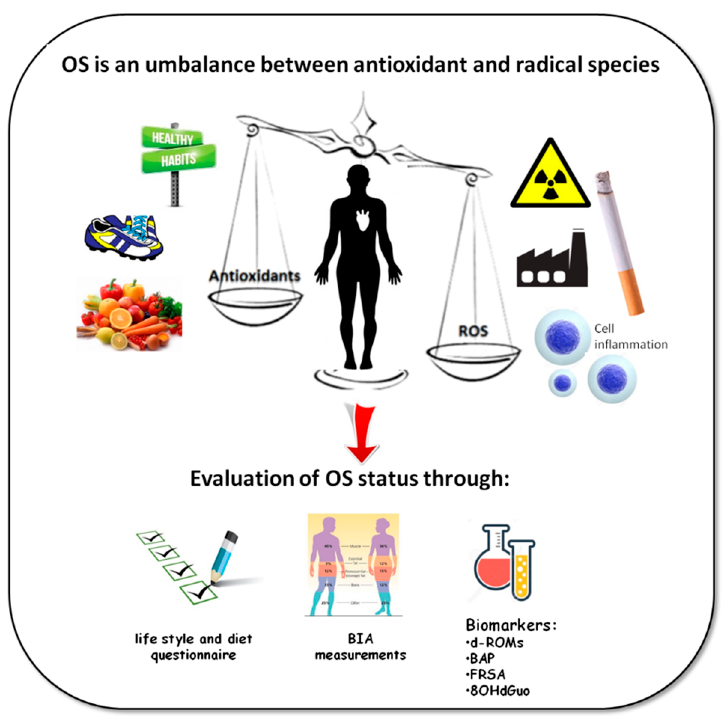
Figure 1. Study design: evaluation of biological markers of OS in a healthy middle age adult group in relation to exercise training, taking into account the influence of environmental and lifestyle factors.